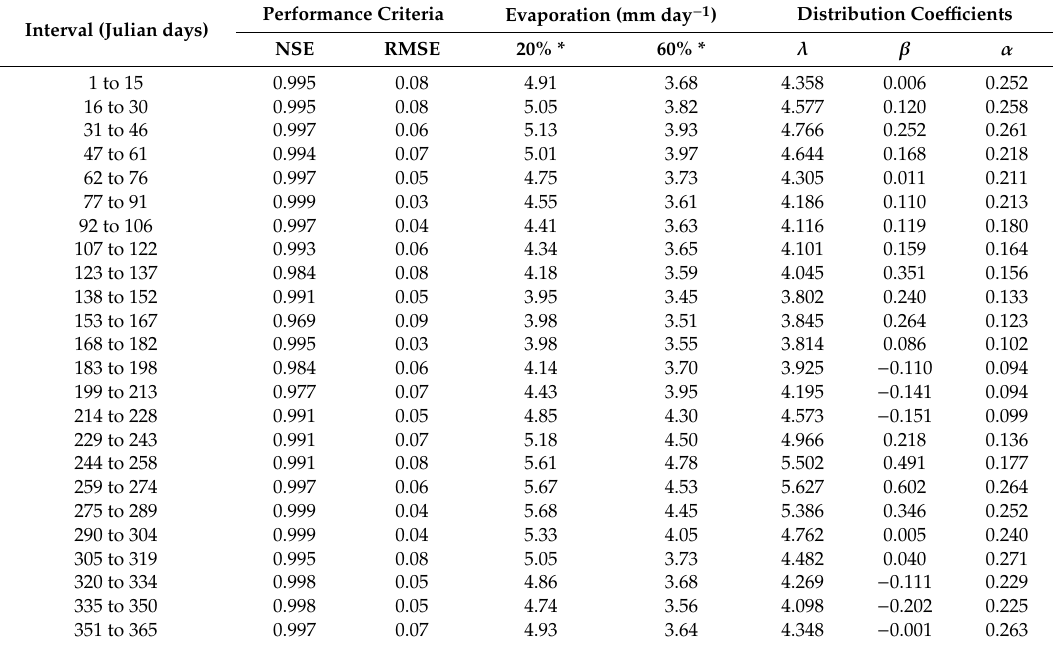
Table 3. Performance criteria, probable evaporation, and adjusted curve coe ffi